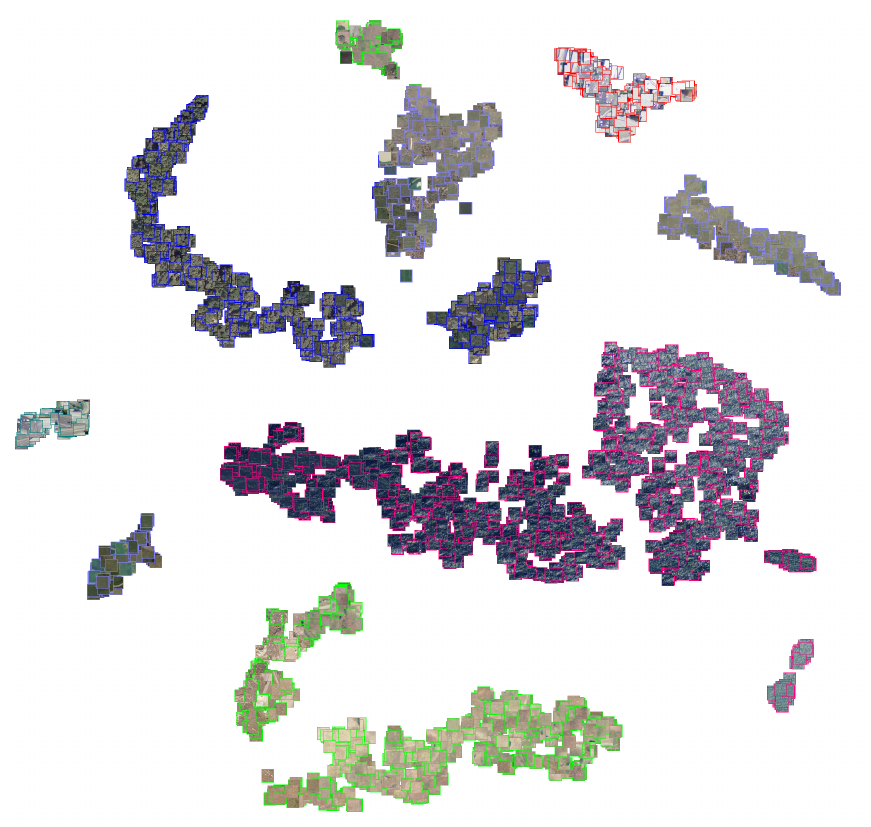
Figure 4: Qualitative evaluation based on the t-SNE technique. Results from the SAT-4 (top) and the SAT-6 (bottom) datasets are presented. Different classes are defined with different colours in the borders of the patches. This visualisation corresponds to the last layer of the AlexNet-small